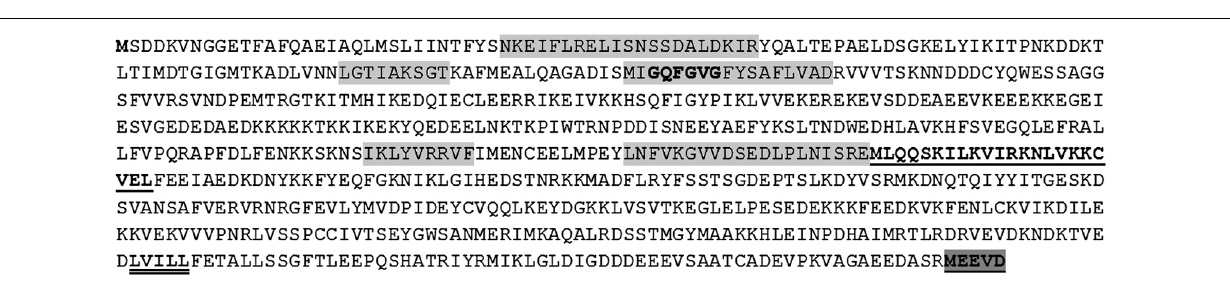
FIGURE 1 | Phylogenetic analysis of the deduced amino acid sequences of Hsp90 isoforms from Heterorhabditis bacteriophora reveals the presence of distinct groupings and the duplication of the retropseudogene Hsp90-2 occurred relatively recently in Heterorhabditis bacteriophora.